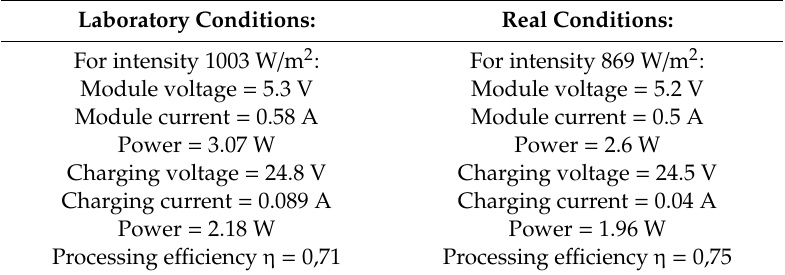
Table 4. Electrical parameters of PV module—LIB device with step-up voltage converters in laboratory and real conditions. Laboratory